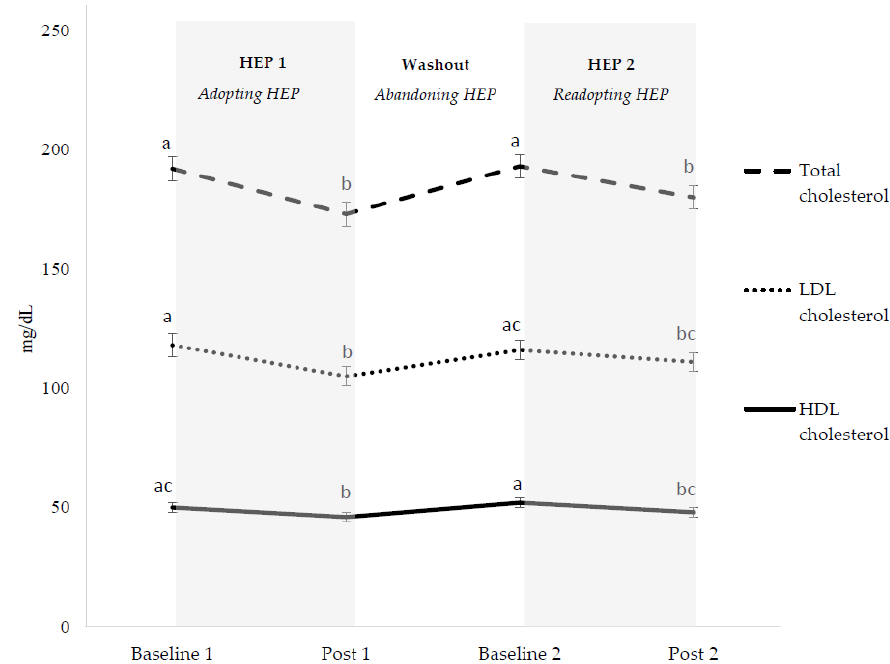
Figure 3. Blood lipid and lipoprotein changes during healthy eating pattern cycling. Results are presented as LS mean ± SEM of LS mean, n = 60. HEP; healthy eating pattern. Subjects consumed self-selected foods during baseline 1, throughout the washout (abandoning) period, and during baseline 2. Subjects consumed healthy eating patterns during post 1 and post 2. Different letter superscripts represent different values ( p < 0.05). Conversion to mmol/L for total, LDL, and HDL cholesterol: multiply mg/dL by 0.0259.